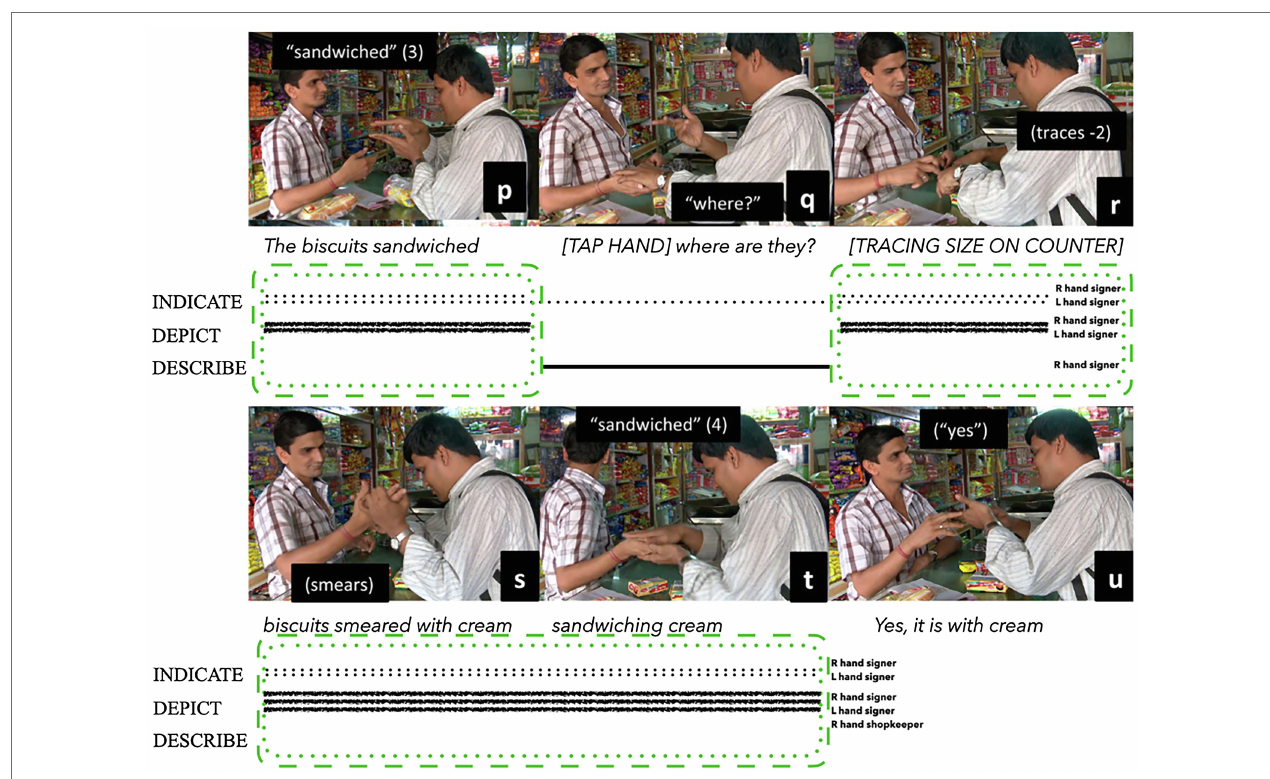
FIGURE 10 | Composite utterance produced by a deafblind Mumbai signer (adapted from Kusters, 2017: 405 and reproduced with permission from the author and Taylor and Francis Group, LLC., a division of Informa plc. The letters p-u pertain to the original